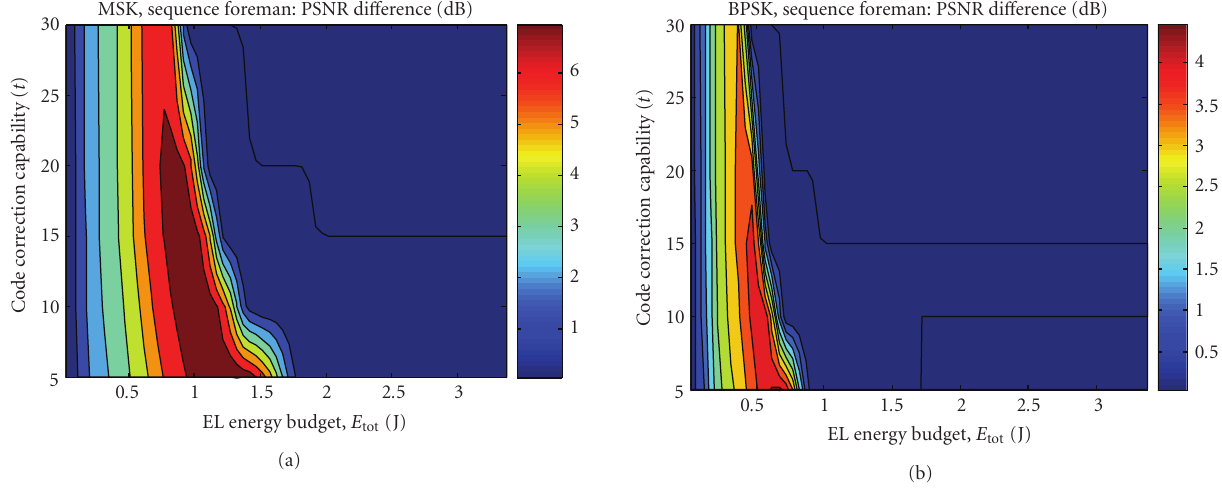
Figure 14: Performance gain of cross-layer UEP against EEP for MSK (a) and BPSK (b)